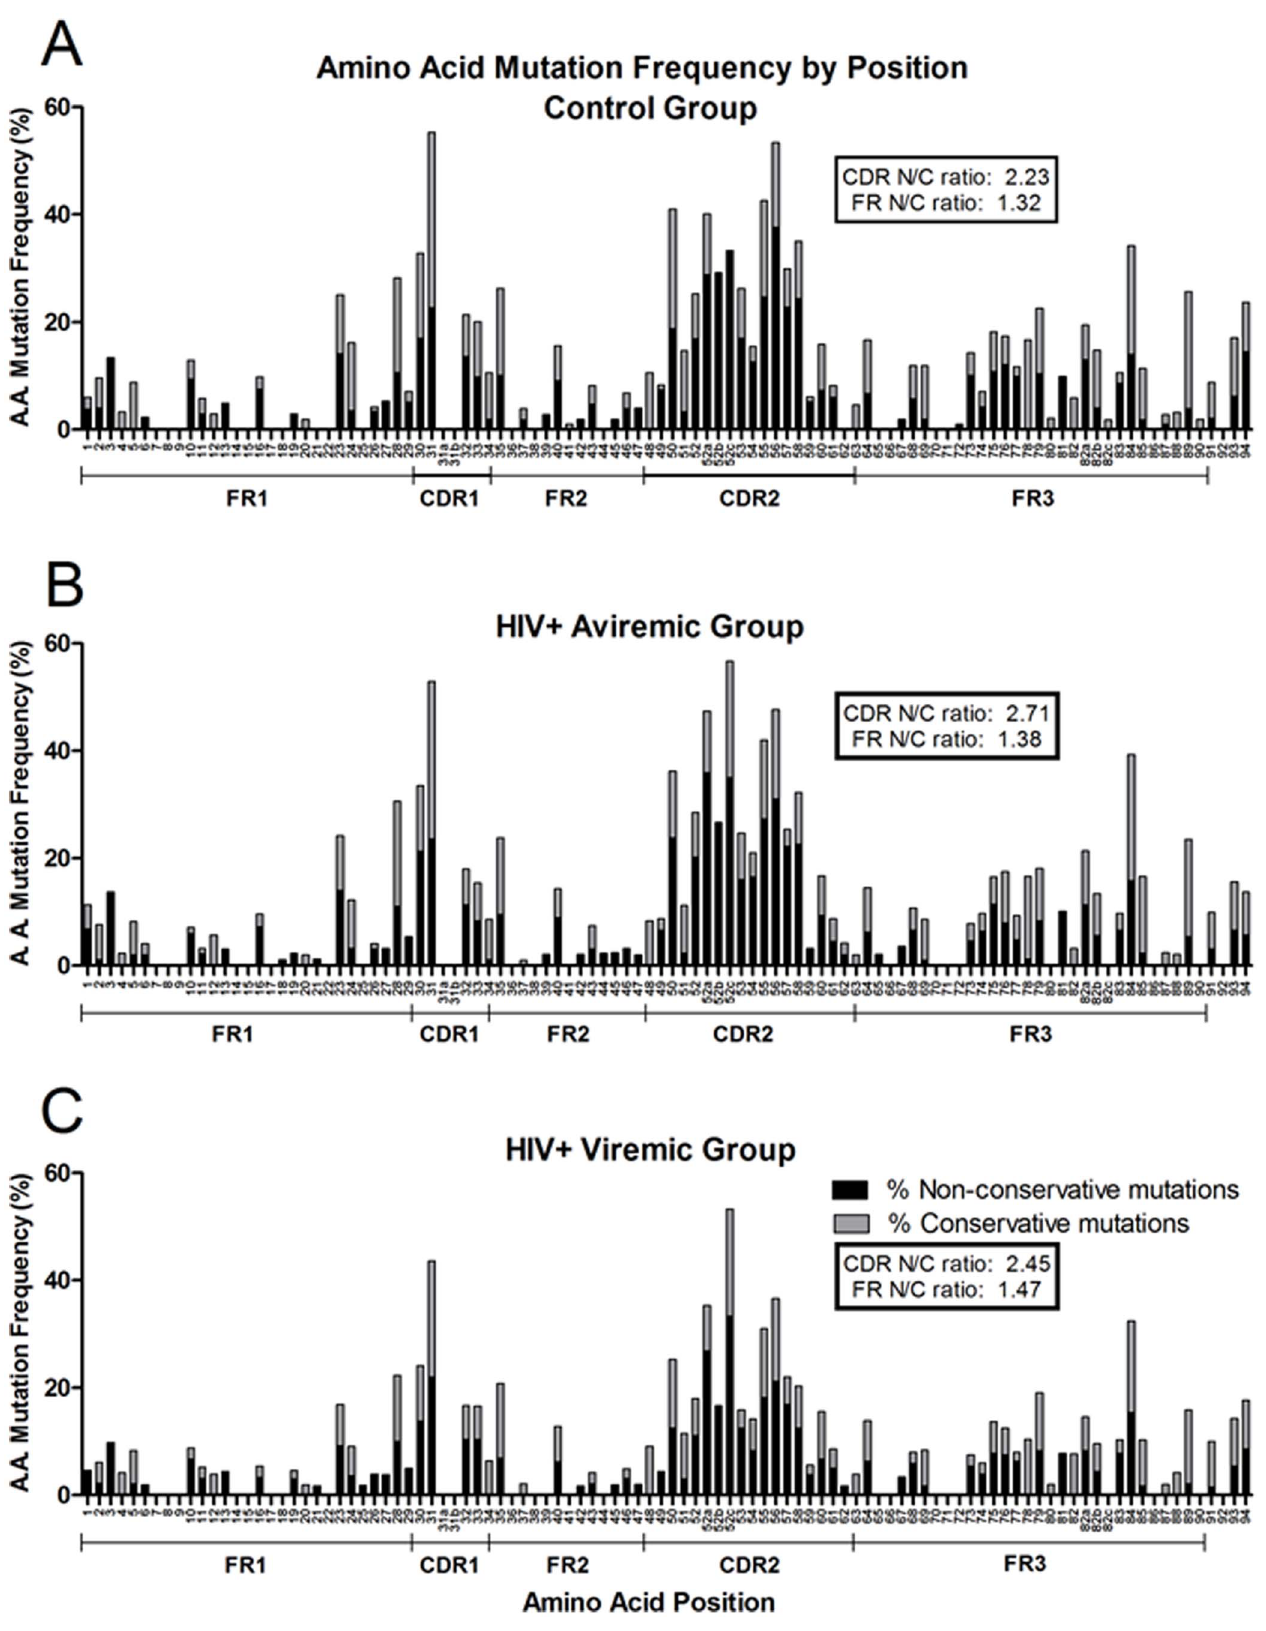
Figure 5. Amino acid mutation frequencies at each position do not differ significantly among groups. The percent of non-conservative (N; black bars) or conservative (C; gray bars) mutations relative to the total number of amino acids sampled at each position (Kabat numbering) are